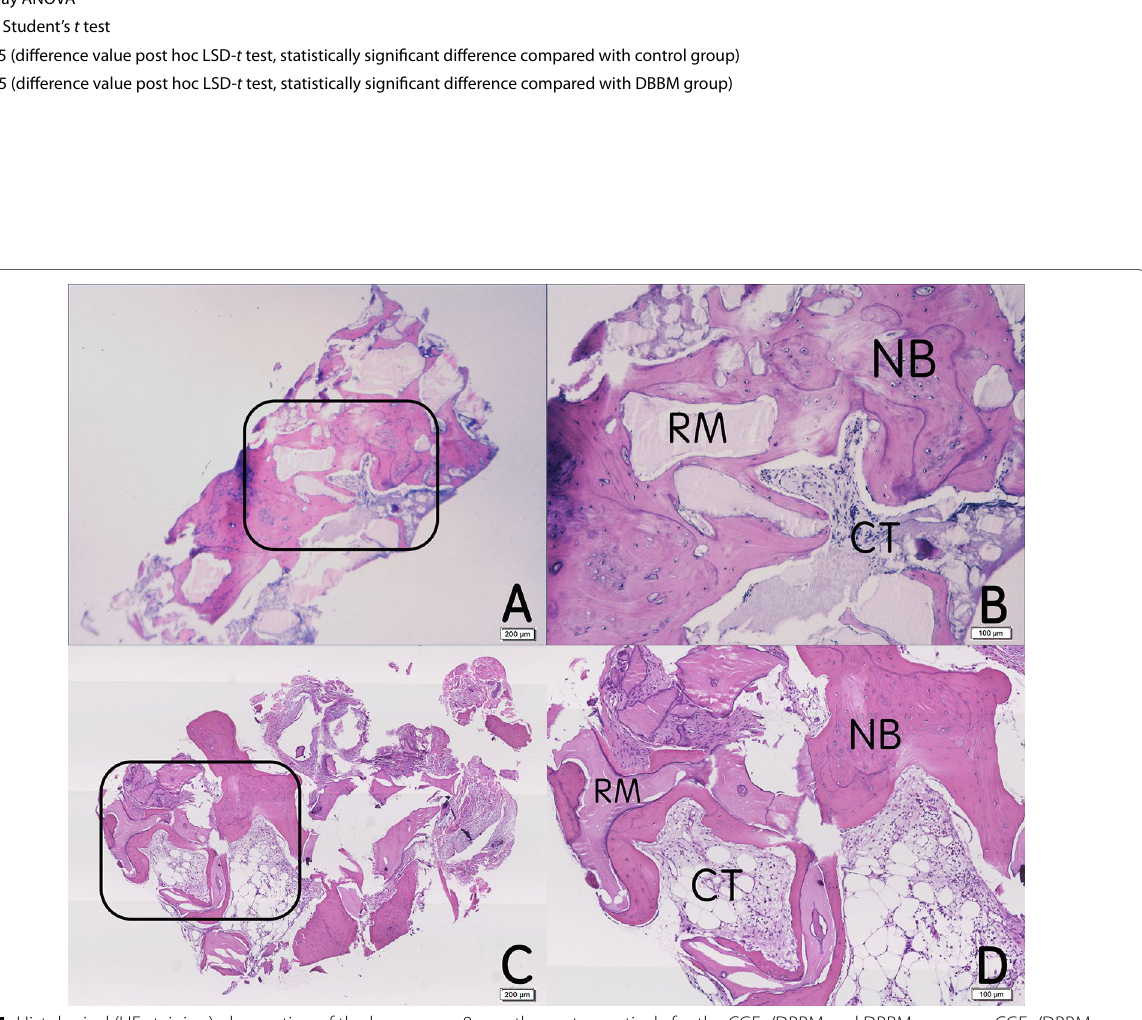
100; c : DBBM group 40; d DBBM group ⅹ 100. NB newly formed bone; RM residual materials; CT connective × ×